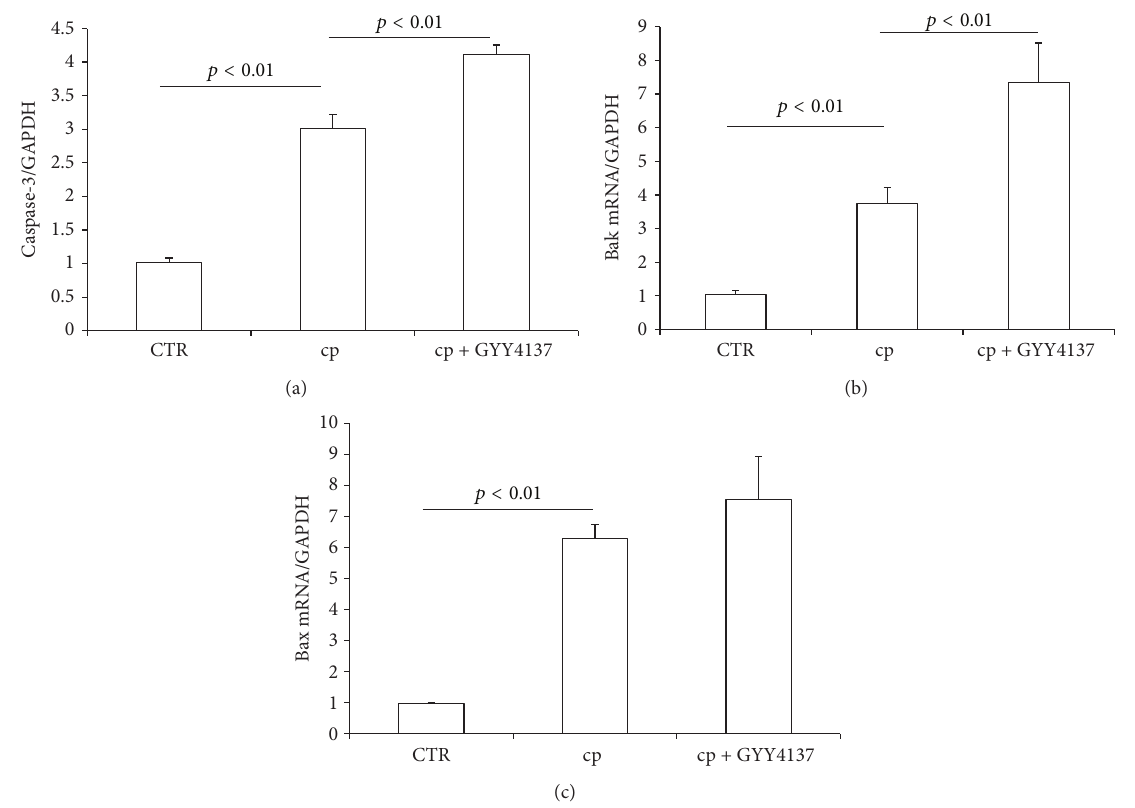
Figure 4: Effects of GYY4137 on cisplatin-induced apoptotic response. (a) qRT-PCR analysis of caspase-3 mRNA expression in kidney. (b) qRT-PCR analysis of Bak mRNA expression in kidney. (c) qRT-PCR analysis of Bax mRNA expression in kidney. CTR: control, 𝑛 = 5 ; cp: cisplatin, 𝑛 = 10 ; and cp + GYY4137: cisplatin + GYY4137, 𝑛 = 10 . Data are means ±